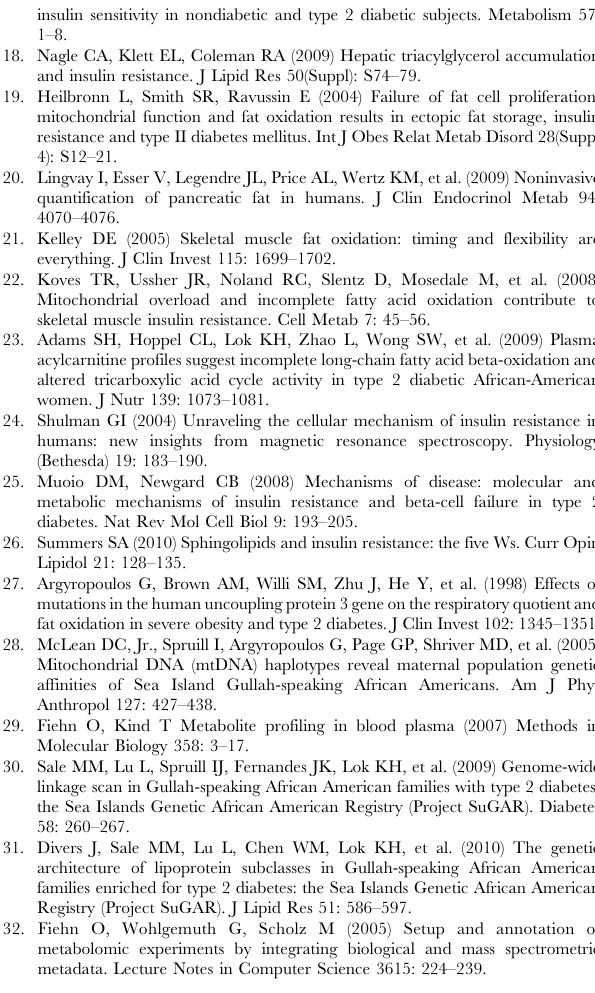
Table S3 Loadings values for each of the principal components (metabolite factors) used to generate sub- ject PC scores depicted in Figure